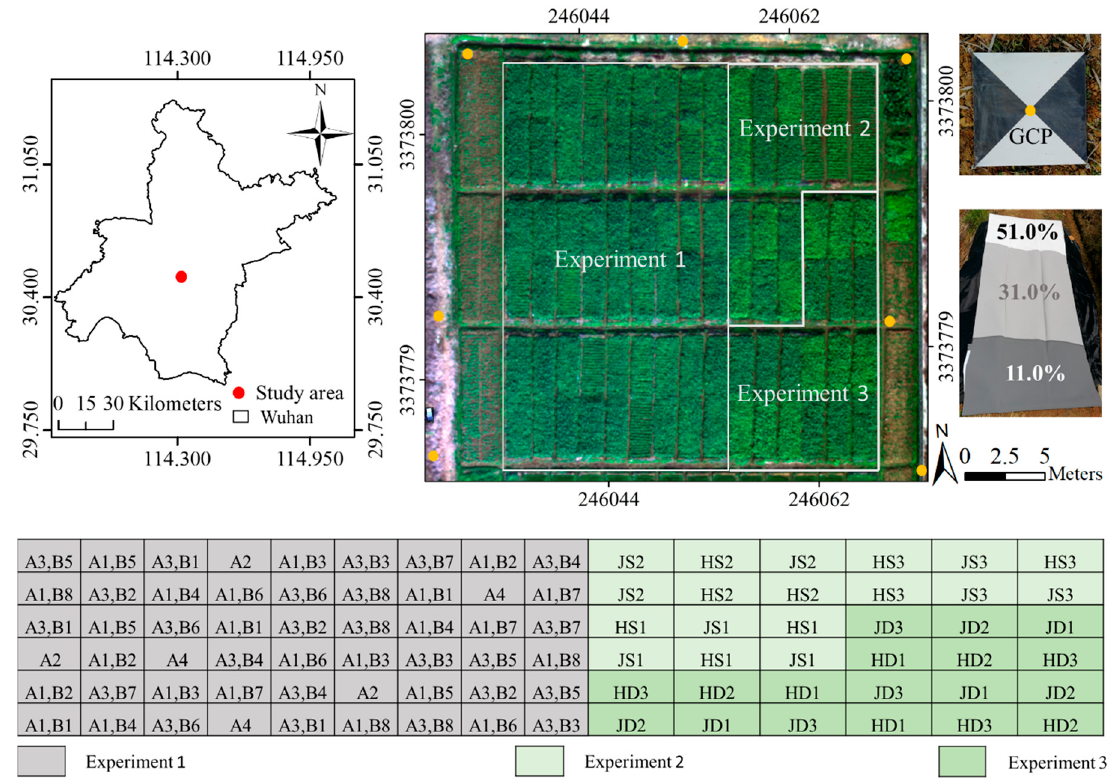
Figure 1. Layout of study area. The white lines were the boundary of study areas of Experiments 1, 2 and 3. The orange dots indicated the locations of ground control points (GCPs). The 11.0%, 31.0% and 51.0% were the reflectance of calibration targets.